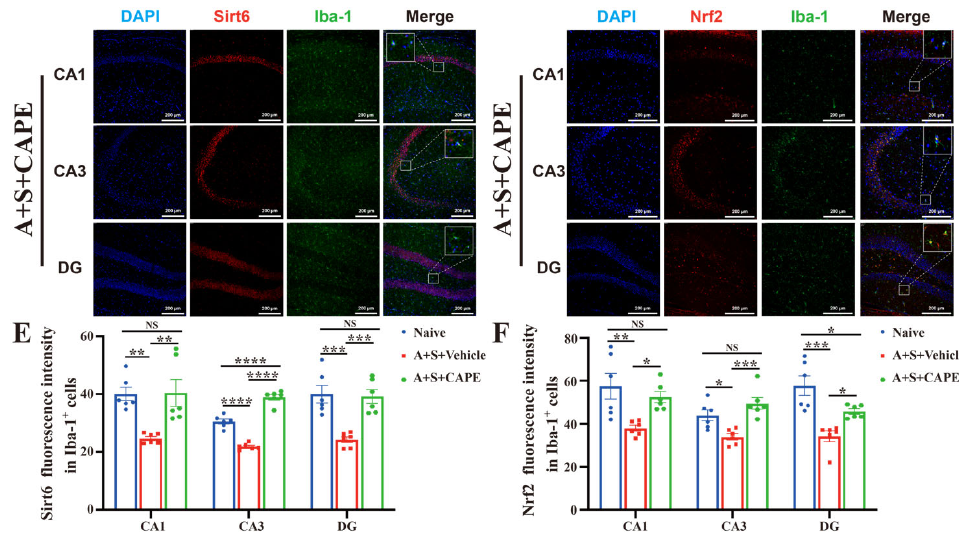
Figure 5. CAPE pretreatment enhances hippocampal Sirt6/Nrf2 signaling pathway after anesthesia